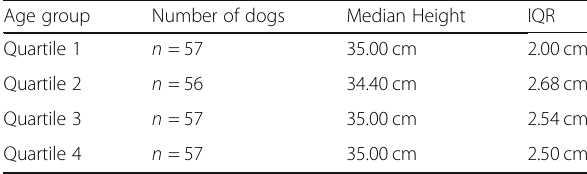
Table 5 Comparison of height and age of PBGV Age